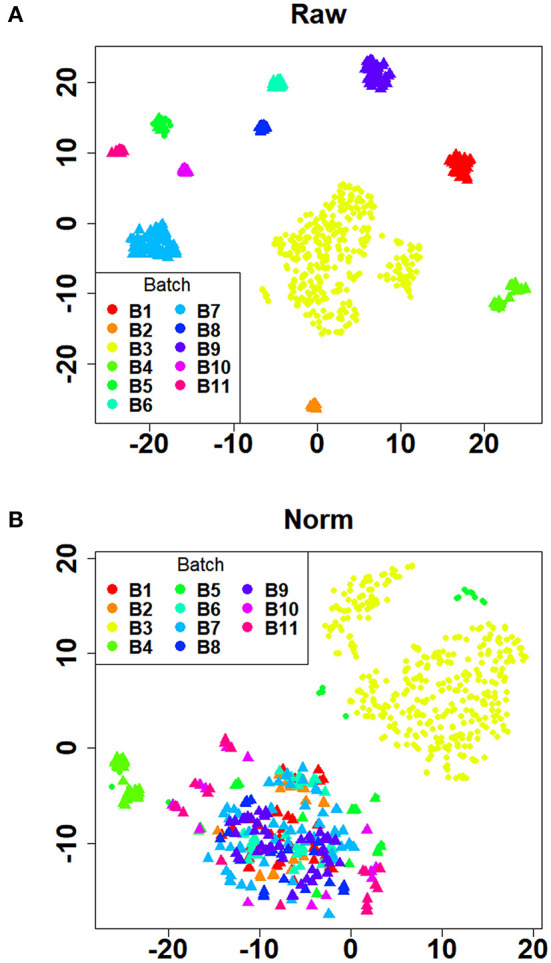
Verification of batch effect removal using t-SNE plots. (A) The distribution of the raw data after dimensionality reduction. (B) The distribution of the batch effect corrected data after dimensionality reduction. The dots with different colors represented samples in different batches. Healthy controls and rheumatoid arthritis samples were denoted by triangles and circles, respectively.